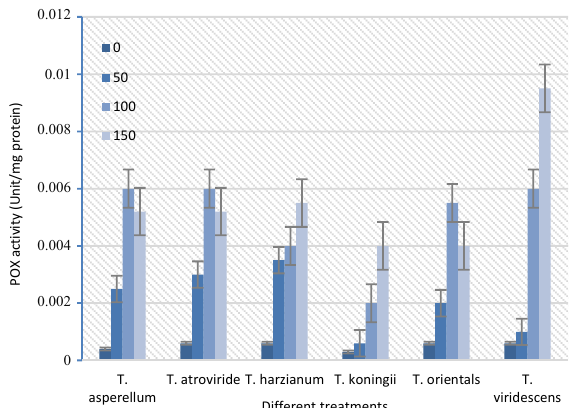
Fig. 3. Peroxidase activity (unit/mg protein) of studied fungal strains at various concentrations of α-naphthol (Peroxidase activity increased at higher α-naphthol concentrations; significant differences between various treatments;